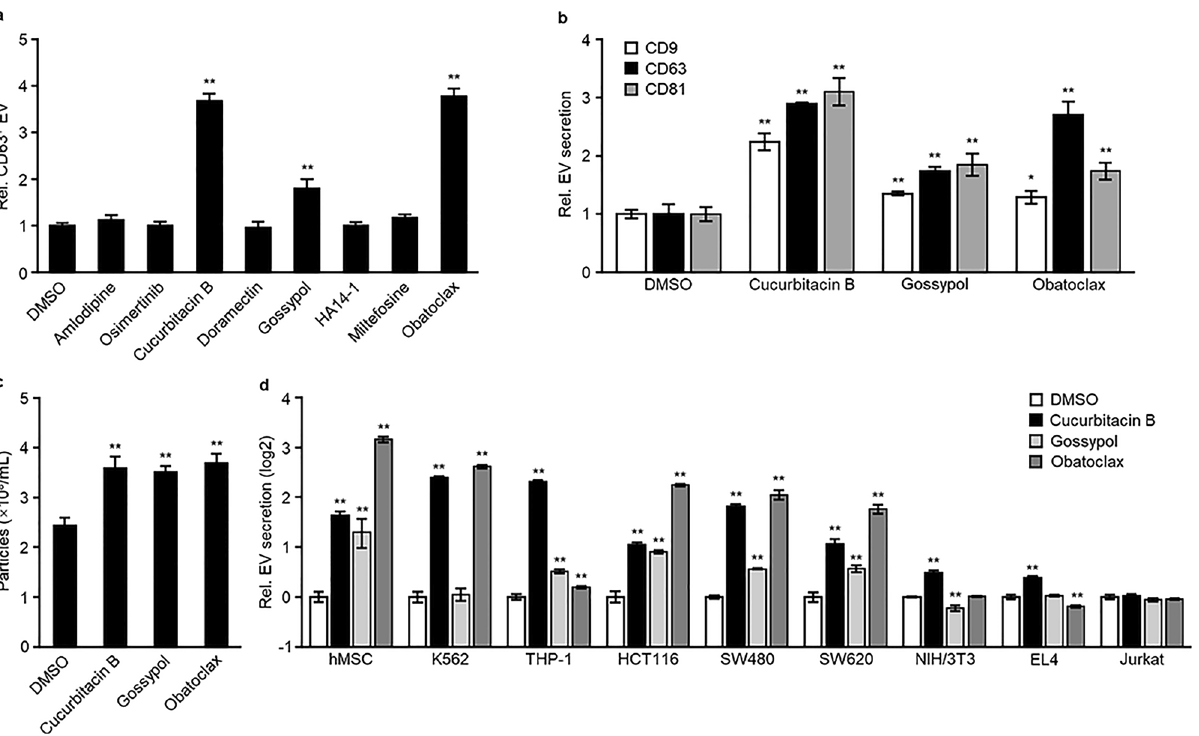
Figure 3. Cucurbitacin B, gossypol, and obatoclax induced EV secretion in a variety of cells. ( a – c ) HEK293T cells were treated with 1 μM amlodipine, 0.3 μM osimertinib, 1 μM cucurbitacin B, 1 μM doramectin, 0.3 μM gossypol, 10 μM HA14-1, 10 μM miltefosine, or 0.03 μM obatoclax for 24 h and then secreted EVs were determined using a TIM4-CD63 ELISA ( a ), TIM4-CD9, TIM4-CD63, TIM4-CD81 ELISA ( b ) or NTA ( c ). ( d ) Cell lines were treated with cucurbitacin B, gossypol, or obatoclax at the concentrations shown on Table 3 for 24 h, and then secreted EVs were determined using a TIM4-ELISA. EVs secreted from hMSC, K562, HCT116, SW480, SW620, and NIH/3T3 cells were detected using TIM4-CD63 ELISA. EVs secreted from THP-1, EL4, and Jurkat cells were detected using TIM4-CD81 ELISA. * p < 0.05, ** p < 0.01, versus DMSO, Student’s t